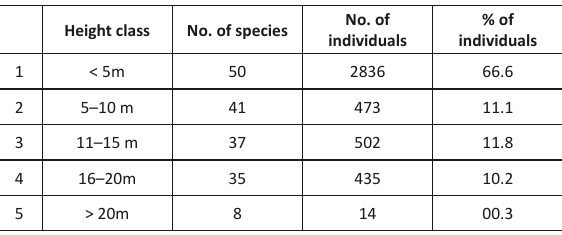
Table 4. Height class-wise proportion of tree individuals. Height class